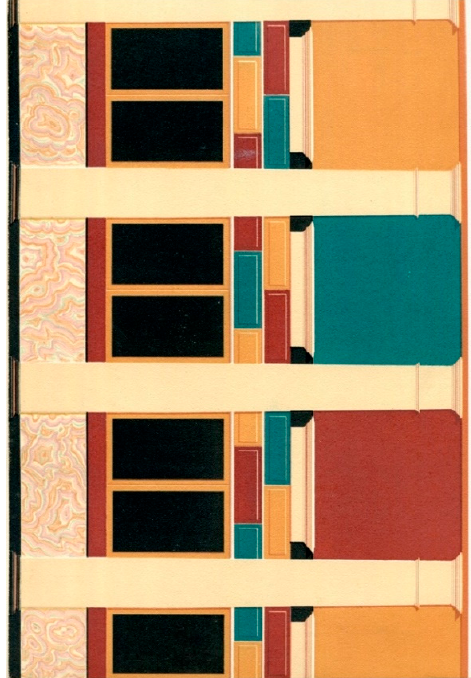
Figure 15. First-style wall from the ‘Officina of Ubonius’ (formerly the rear wall of a peristyle), as depicted in (Mau 1882); repro from (Mau 1882), pl. 2.